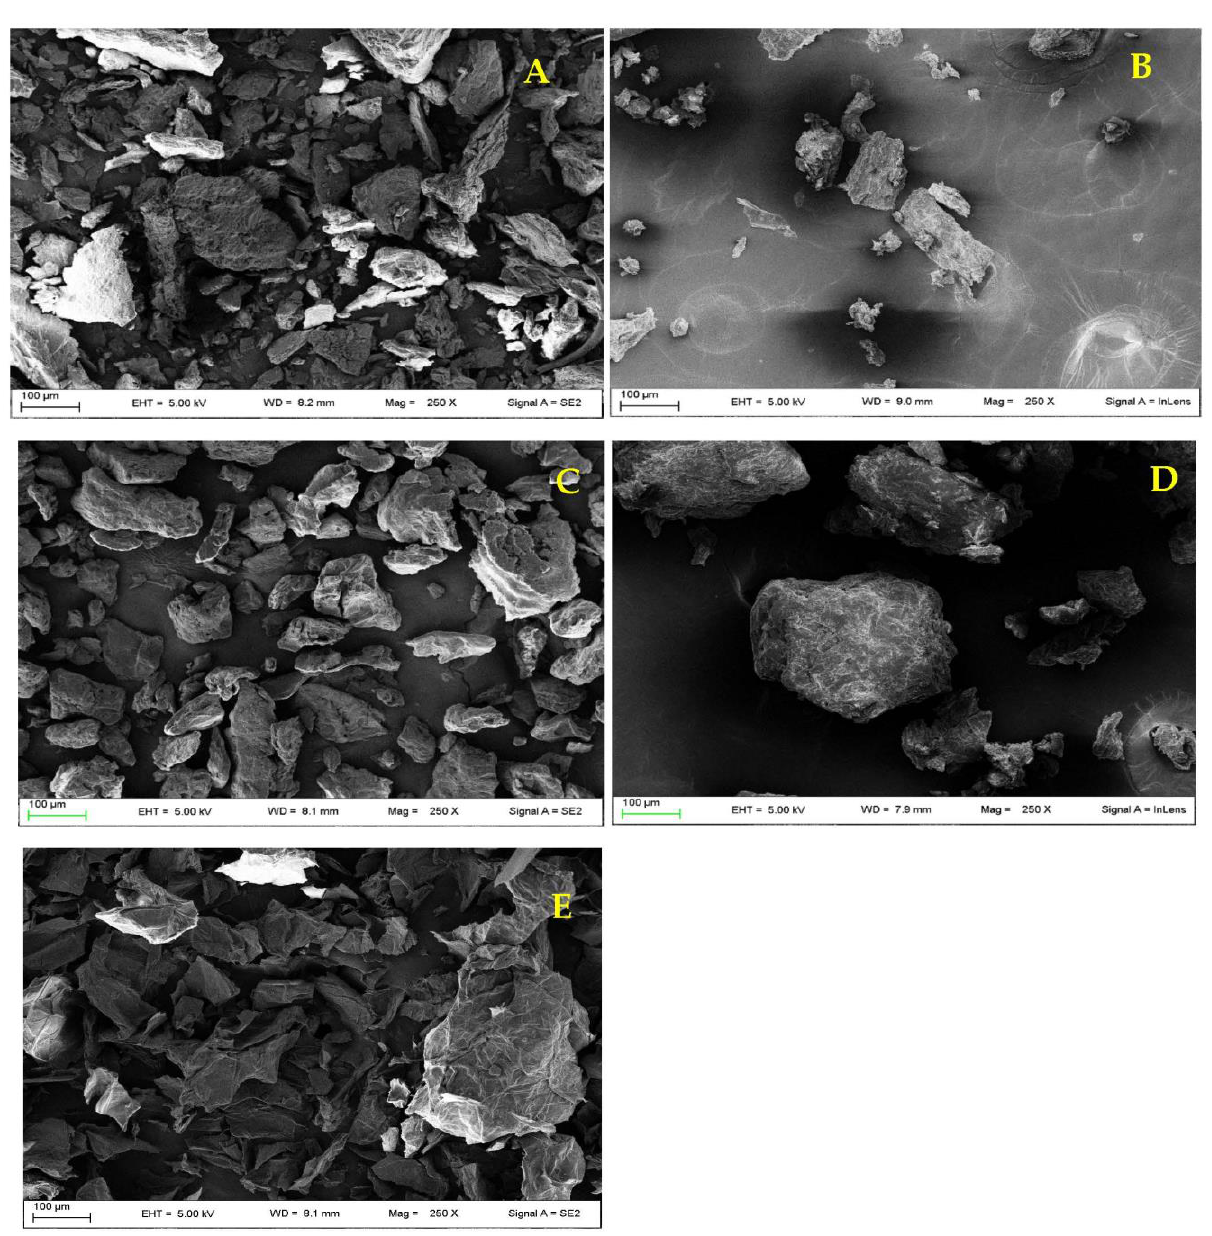
Figure 1. SEM Micrographs (magnification 250X) of AP samples subjected to different drying treat- ments: OD ( A , B ); HOD ( C , D ) and HFD ( E ). treatments: OD ( A , B ); HOD ( C , D ) and HFD ( E